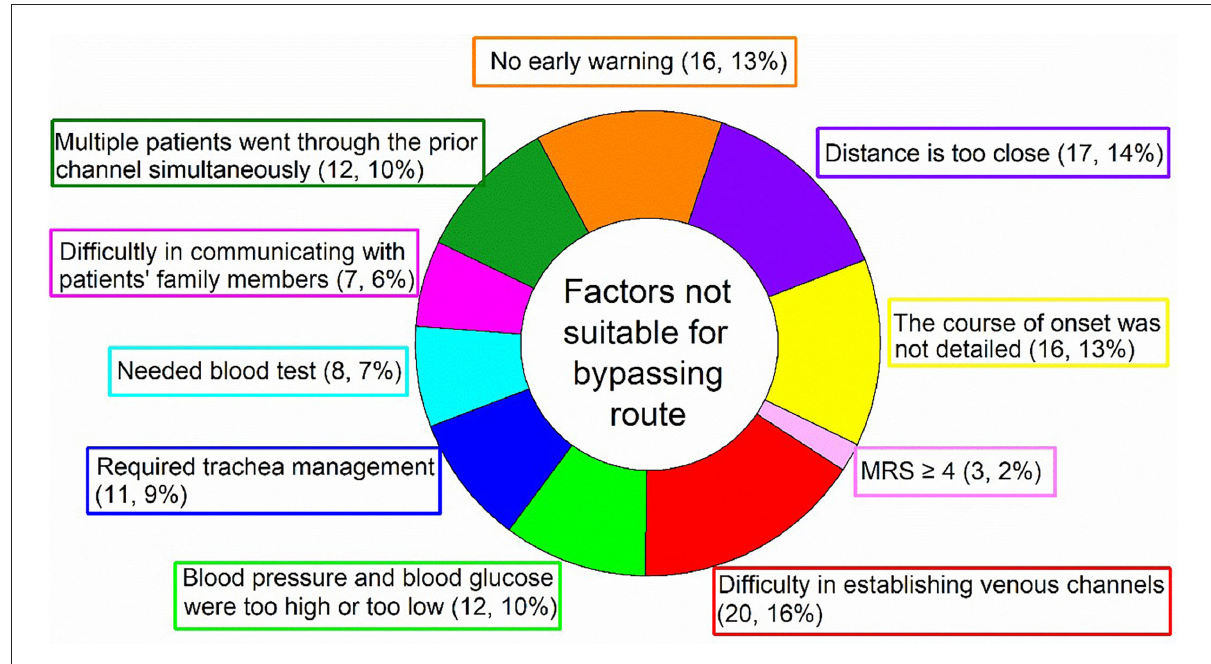
FIGURE6 Factors unsuitable for bypassing emergency route. MRS, modified rankin